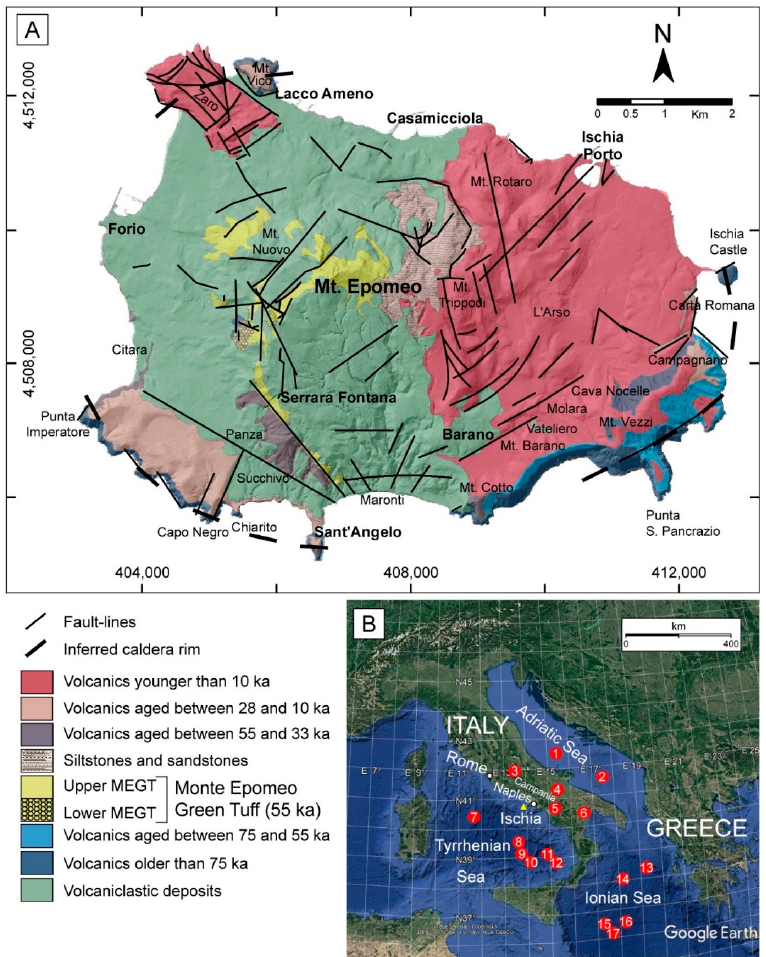
Figure 1. ( A ) Geological sketch map of Ischia island, showing the areal distribution of the main volcanic units, including the Monte Epomeo Green Tuff (modified after D’Antonio et al., 2013 [19]). ( B ) Map of the central Mediterranean area; numbered red circles indicate the main distal locations where the MEGT products have been either recognised or